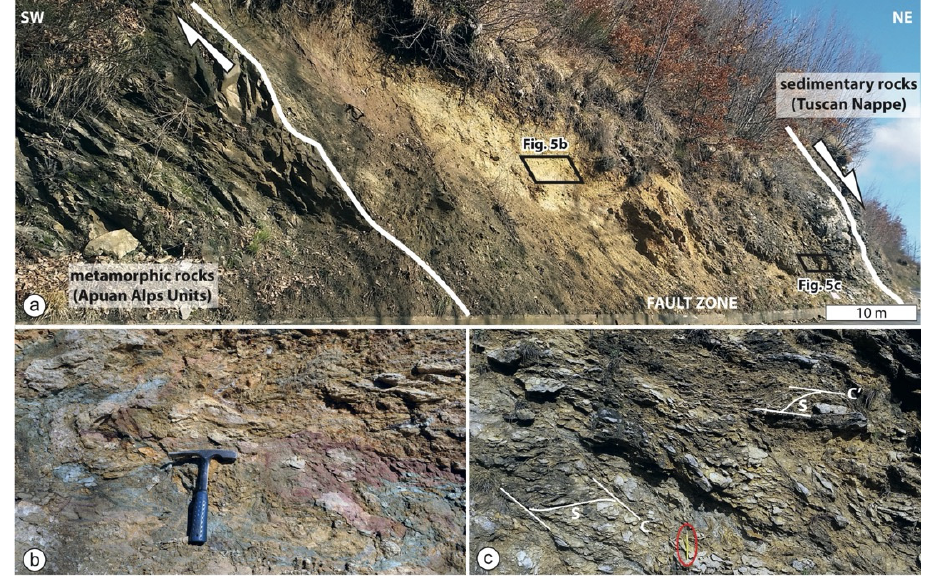
Figure 5. The Apuan Alps tectonic window geosite: mesoscopic features. ( a ) Outcrop along a roadcut of the Apuan Alps tectonic window contact. The metamorphic (Apuan Alps units; on the left ) and non-metamorphic (Tuscan Nappe; on the right ) rocks are separated by several 10s of metre thick low-angle fault zone that preserves the transition from fault gouge ( b ) to foliated cataclasites ( c ) (pen pencil for scale).